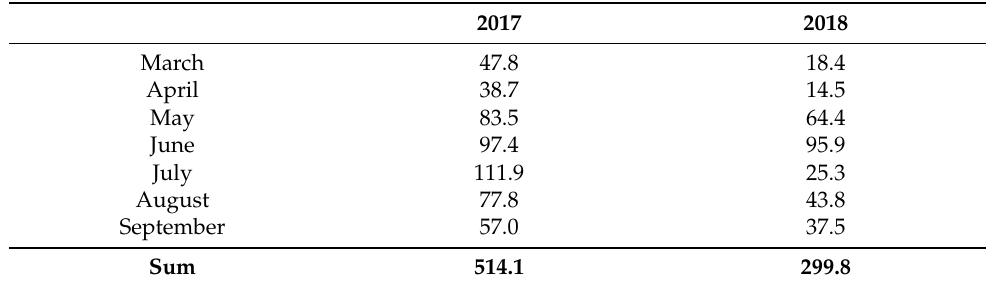
Table 1. Precipitation in mm for the months of March until September in the years 2017 and 2018 for the location Ihinger Hof.